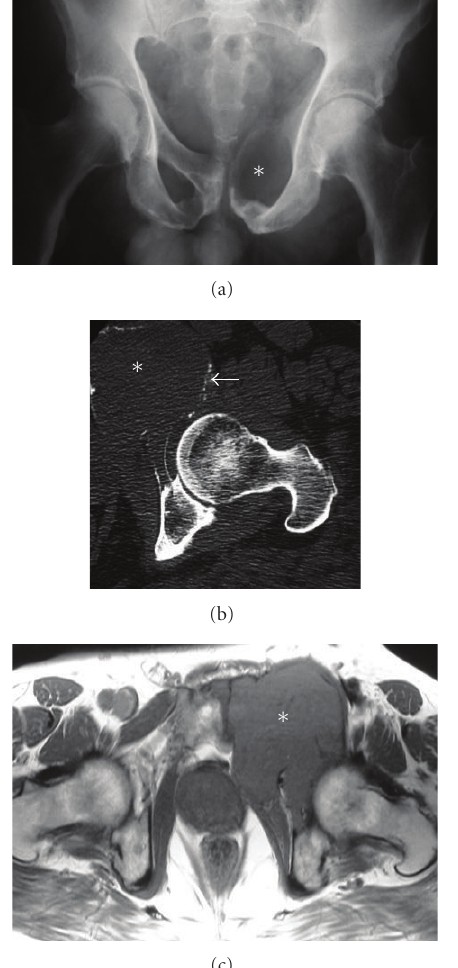
Figure 5: Plasmacytoma. A 68-year-old male with plasmacytoma. Radiographs (a) of the pelvis showing expansion of the left obturator foramen and an expansile osteolytic lesion involving the superior pubic ramus (asterisk). Axial CT (b) depicts the large lytic mass expanding the superior pubic rami (asterisk). A thin mineralized periphery in keeping with expanded cortex is appreciated on CT (arrow). Axial T1 MR (c) demonstrates the expansile mass (asterisk) displacing the left femoral vessels, indenting the left anterolateral aspect of the prostate and invading the adjacent obturator internus muscle.